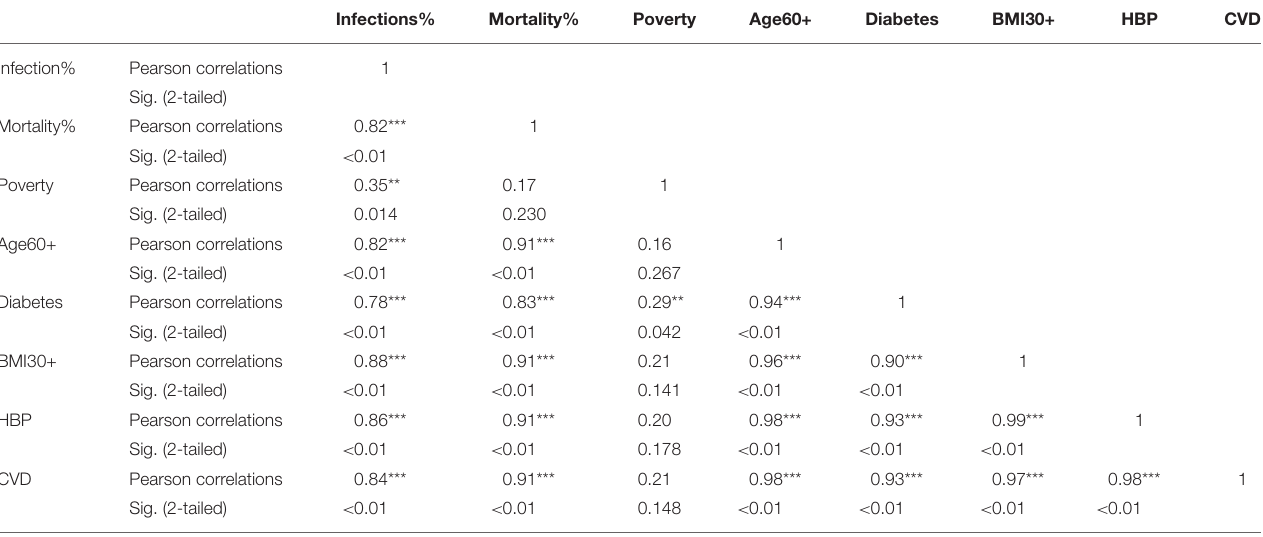
TABLE 3 | Pearson correlations for NHW ethnic group between variables used in the study and their significance levels. Infections%